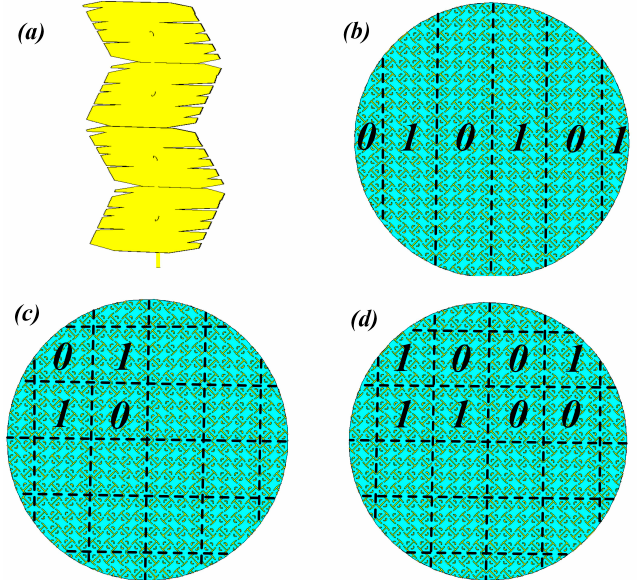
Figure 2. Metallic stirrer ( a ), periodic metasurfaced stirrer with coding sequences 0101 . . . /0101... ( b ) and 0101 . . . /1010 . . . ( c ), and 1-bit random coding metasurfaced stirrer ( d ).